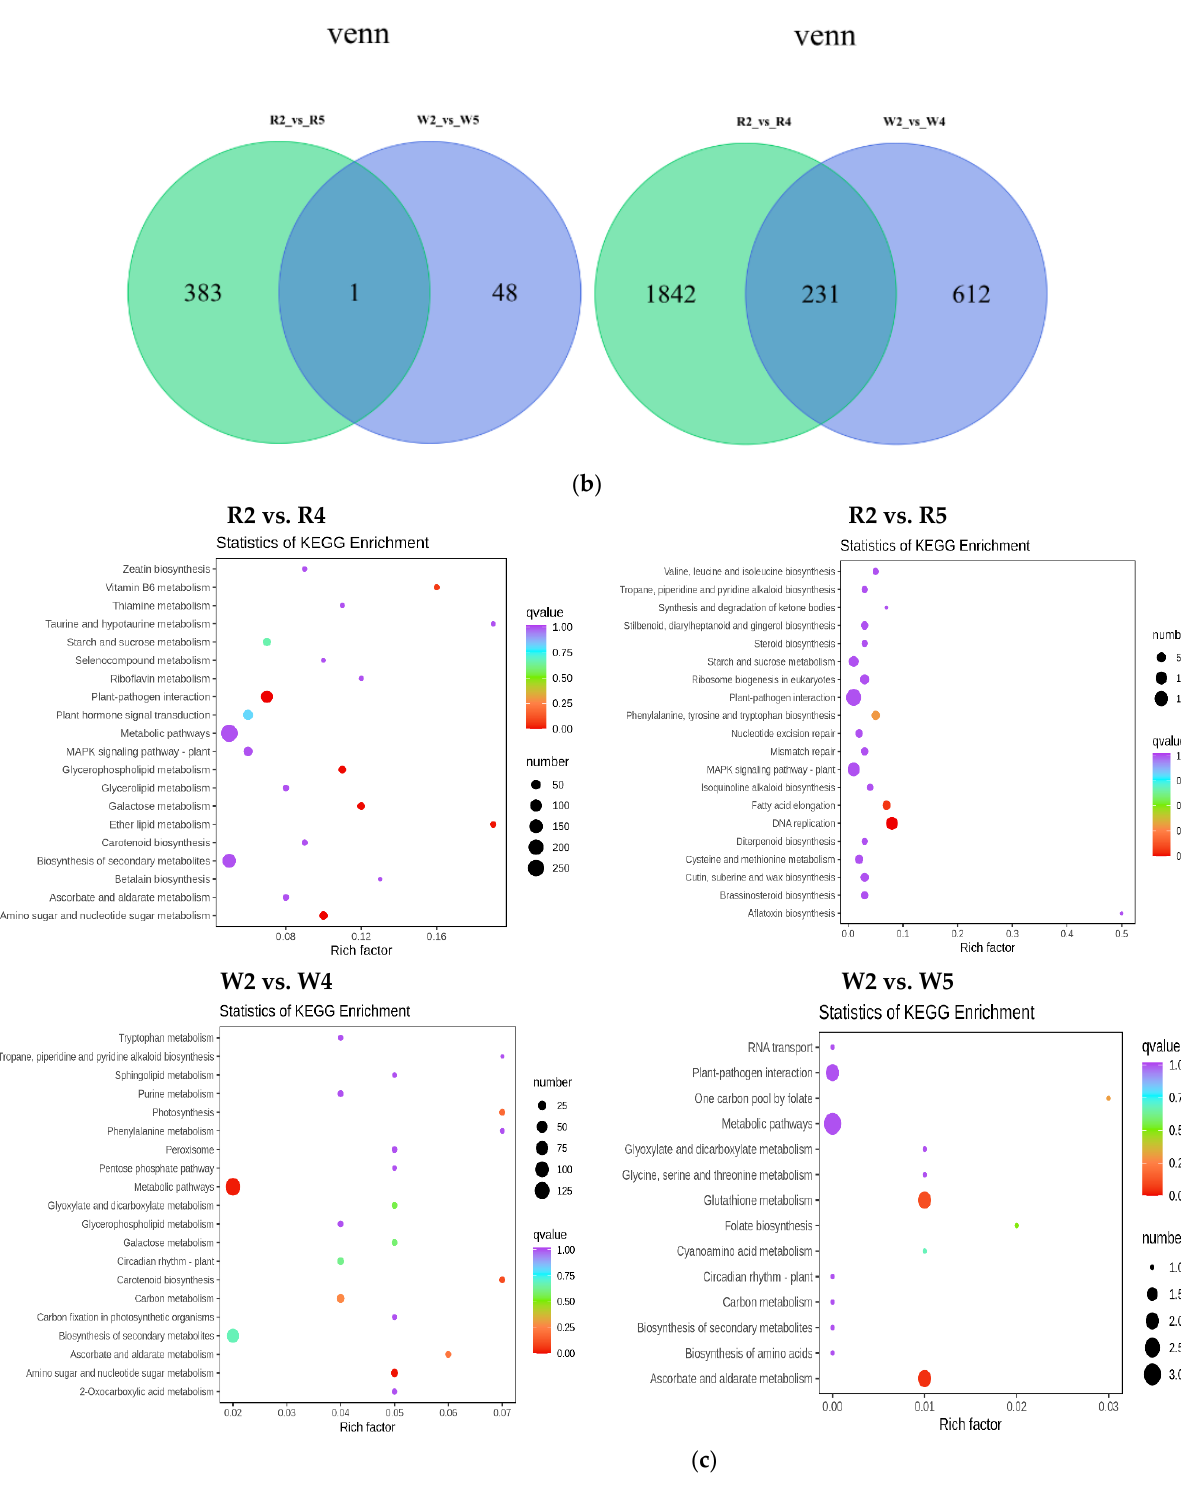
Figure 6. ( a ) Volcano map of DEGs; R2 vs. R4, R2 vs. R5, W2 vs. W4, and W2 vs. W5 (from left to right). Abscissa represents multiples of changes in gene expression. Ordinate represents DEGs significance levels. Red and green dots represent upregulated and downregulated DEGs, respectively. Blue dots represent non-DEGs. ( b ) Venn diagram of DEGs; CK vs. LP and CK vs. HP. ( c ) Enrichment scatter diagram; R2 vs. R4, R2 vs. R5, W2 vs. W4, and W2 vs. W5 (from left to right). The ordinate and abscissa represent the KEGG pathway and rich factor, respectively. The degree of enrichment increases with rich factor. The dot size is proportional to the number of enriched DEGs in the pathway. Red color intensity increases with enrichment